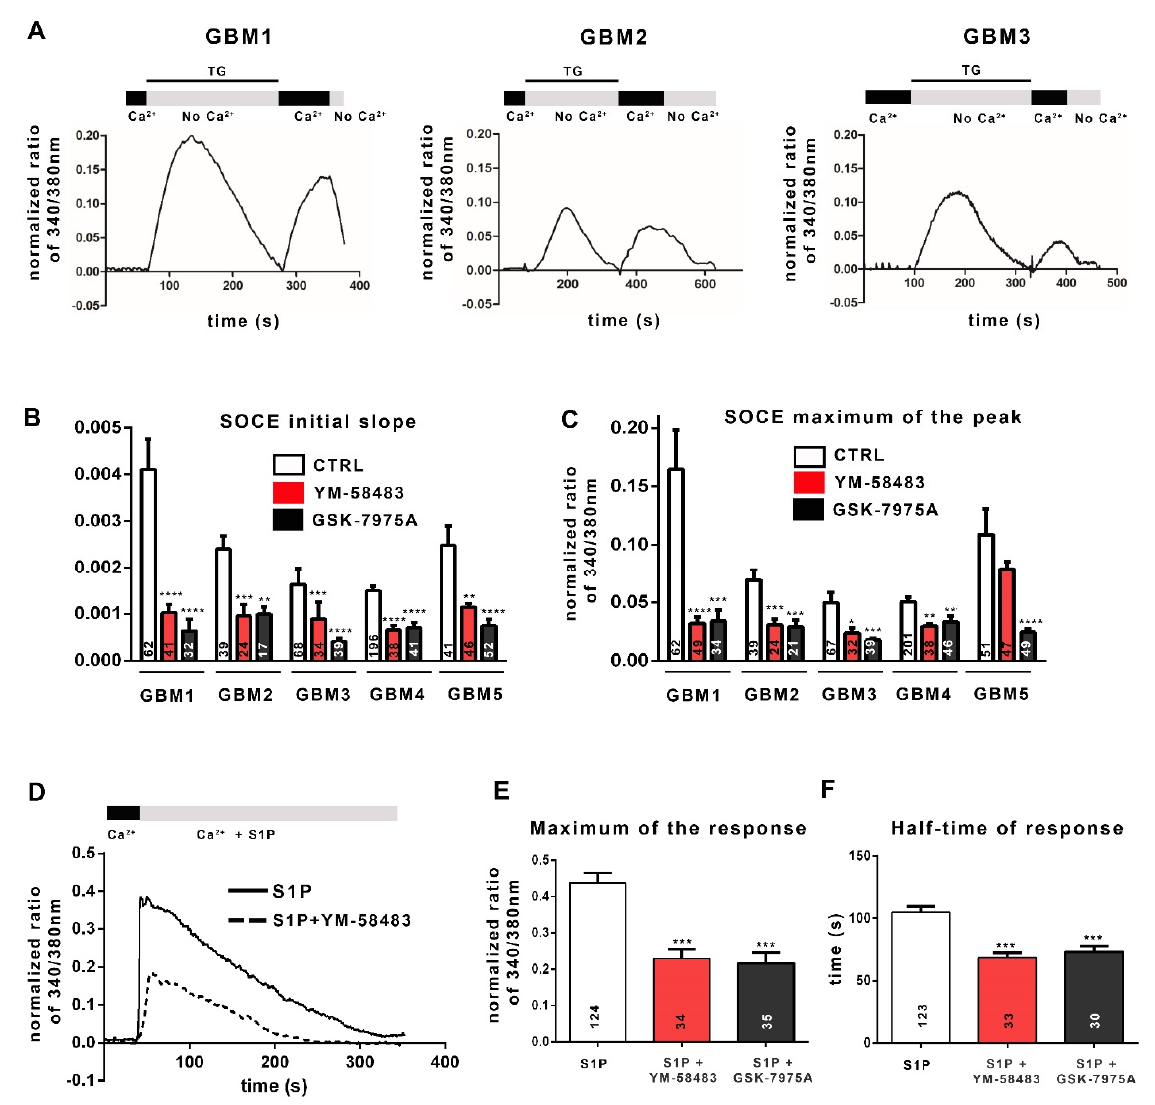
Figure 2. Cancer stem cells from GBM display SOCE. ( A ): Examples of representative traces of SOCE recorded in GSC cultures. The traces shown here have been recorded in GBM1 cells, GBM2 cells and GBM3 cells. To obtain these traces, cells were loaded with Fura-2AM and then incubated in a 0 mmol·L − 1 Ca 2+ solution (No Ca 2+ ) containing 4 μ mol·L − 1 thapsigargin (TG), leading Ca 2+ release from the ER (first peak). Replacement of the 0 mmol·L − 1 Ca 2+ solution with 1.8 mmol·L − 1 physiological Ca 2+ buffer (Ca 2+ ) induced Ca 2+ entry through SOC (second peak, SOCE). ( B , C ): Bar graphs repre- senting the average initial slope of the ascending phase during Ca 2+ influx ( B ) or the average maximum of Ca 2+ influx ( C ). SOCE were recorded in 1.8 mmol·L − 1 Ca 2+ with the addition of DMSO (control, white bars), or YM-58483 (GBM1, GBM2 and GBM5 were treated with 1 μ mol·L − 1 and GBM3 and GBM4 with 5 μ mol·L − 1 , red bars), or GSK-7975A (GBM1 and GBM2 were treated with 1 μ mol·L − 1 and GBM3, GBM4 and GBM5 with 5 μ mol·L − 1 , black bars). Data represented as means ± s.e.m were obtained from recordings on at least 3 different experiments ( n = 5 for GBM1, n = 3 for GBM2 and GBM3, n = 6 for GBM4, n = 4 for GBM5). The values inside the bars correspond to the numbers of recorded cells from which the data are derived. * p < 0.05, ** p < 0.01, *** p < 0.001, **** p < 0.0001. ( D ): Representative trace of the response to 1 μ mol·L − 1 of sphingosine 1-phosphate (S1P) in the absence (solid line) or presence (dashed line) of 1 μ mol·L − 1 of YM-58483 in GBM1 cells. ( E , F ): Quantification of the S1P (1 μ mol·L − 1 ) response by measuring the peak of calcium entries (maximum of re- sponse) ( E ) and with half the response time to reach the “plateau” phase ( F ) with the addition of DMSO (control, white bars, S1P), or 1 μ mol·L − 1 YM-58483 (red bars, S1P + YM-58483), or 1 μ mol·L − 1 GSK-7975A (black bars, S1P + GSK-7975A).